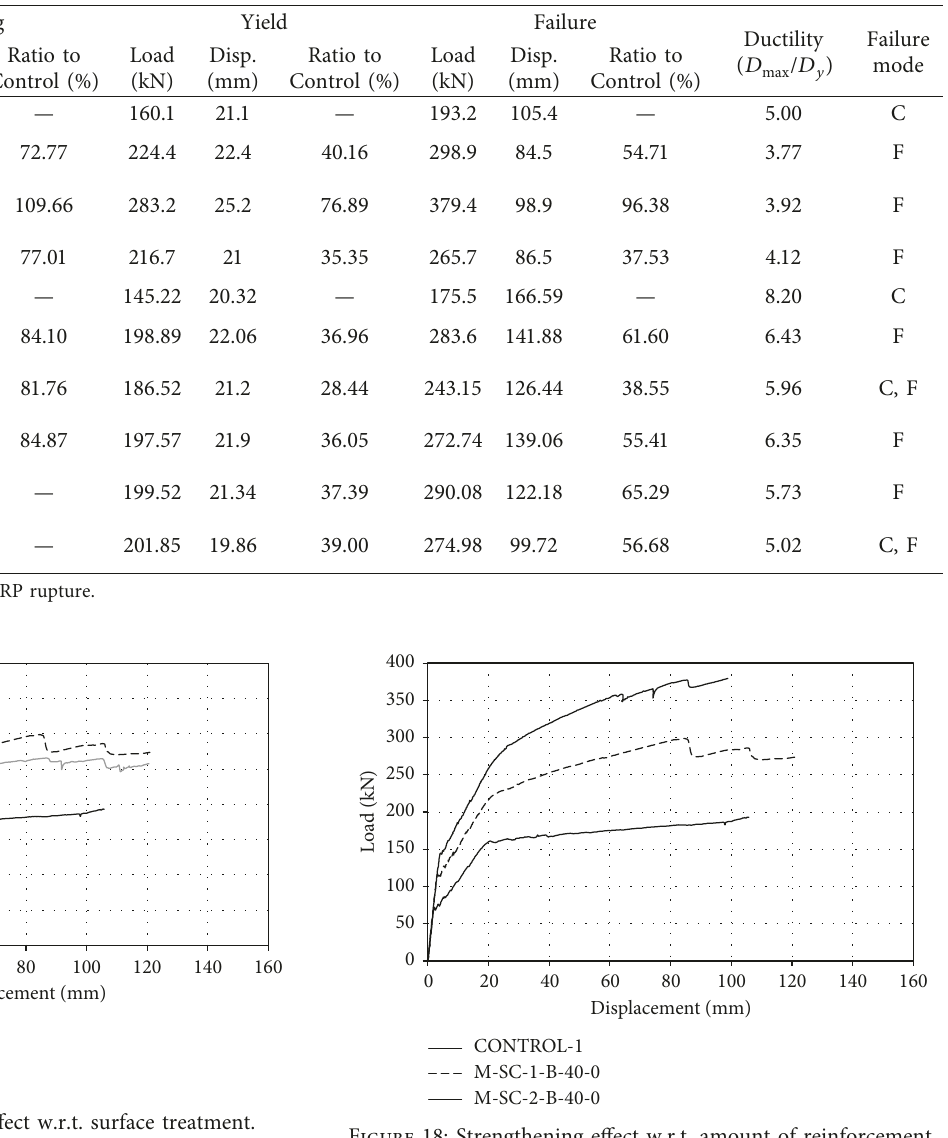
Figure 18: Strengthening effect w.r.t. amount of